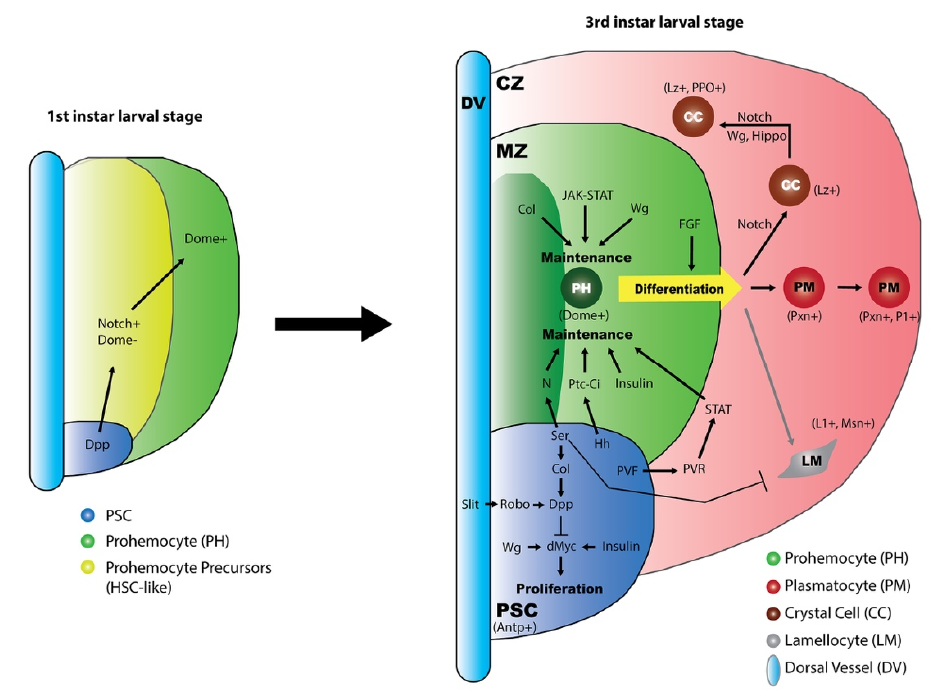
Figure 2. The regulation of lymph gland development by developmental signalings.